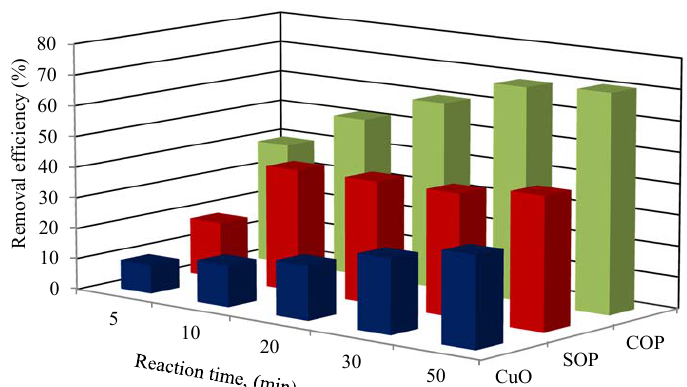
Fig. 4: The effect of contact time on benzene removal efficiency